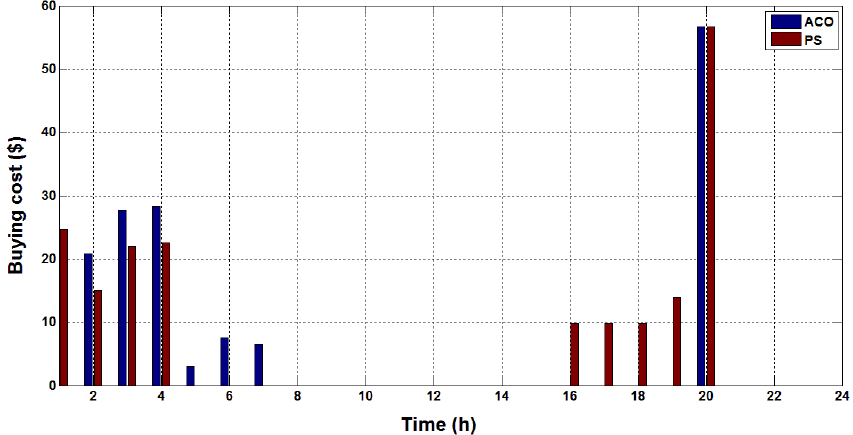
Figure 11. Grid power purchasing cost comparison.